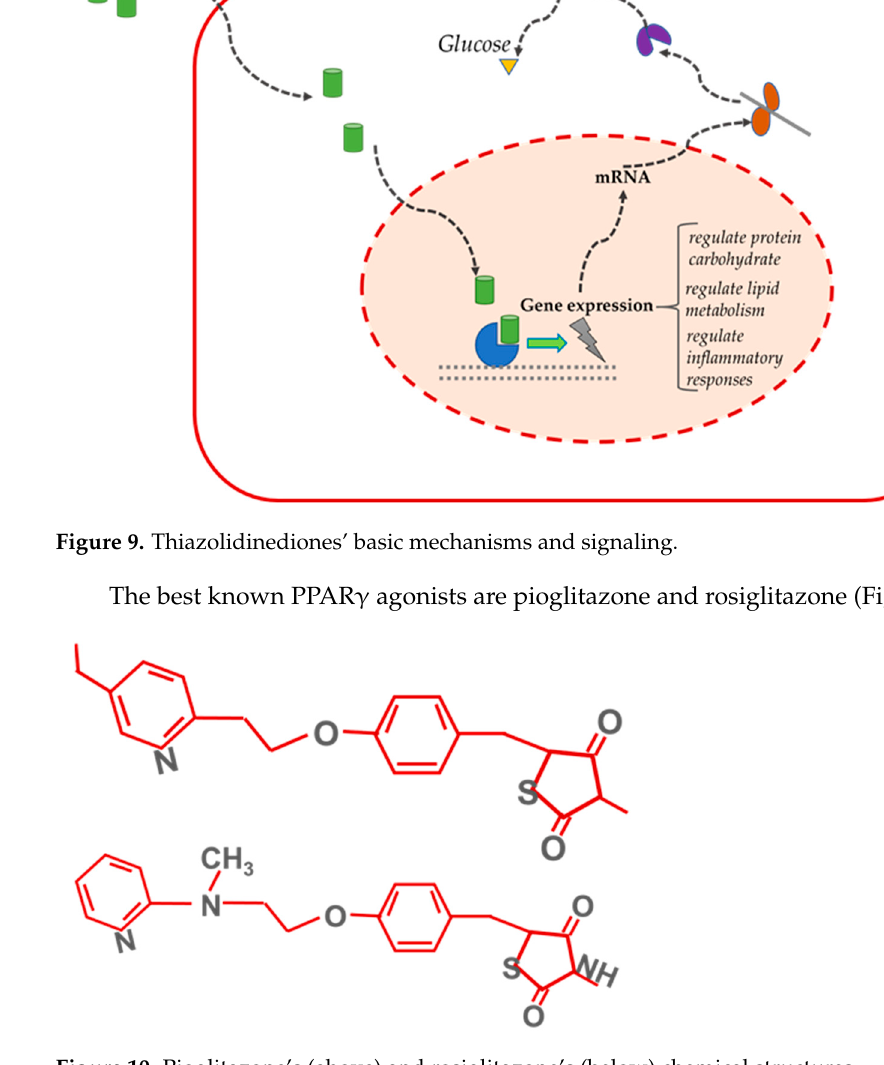
Figure 10. Pioglitazone’s (above) and rosiglitazone’s (below) chemical structures.